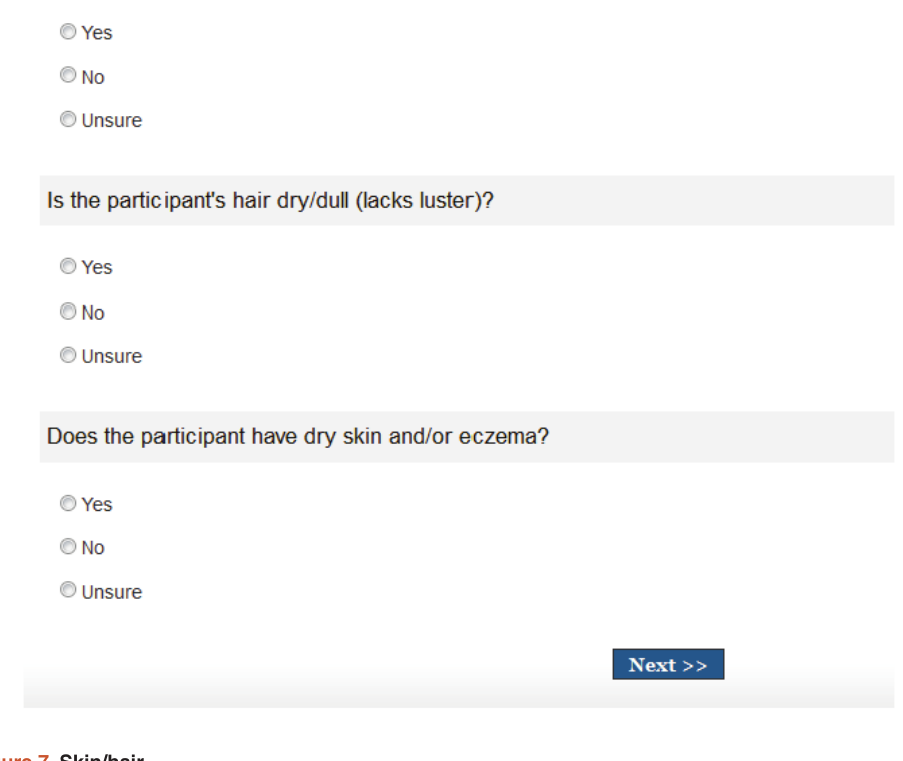
Supplemental Figure 7.